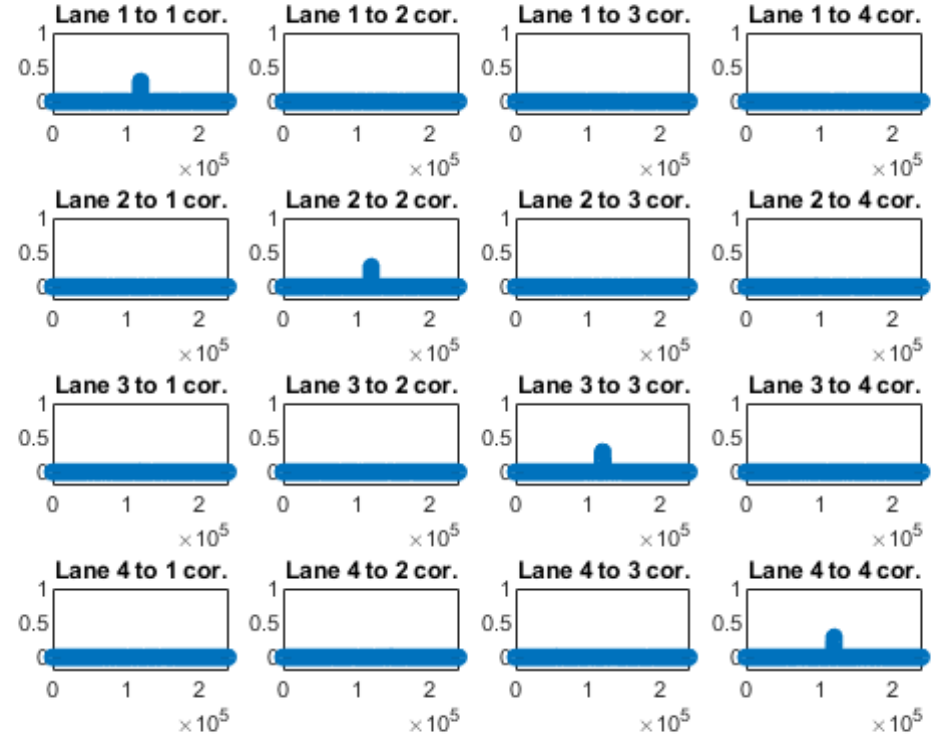
Figure 14. Correlations between perturbation signals.